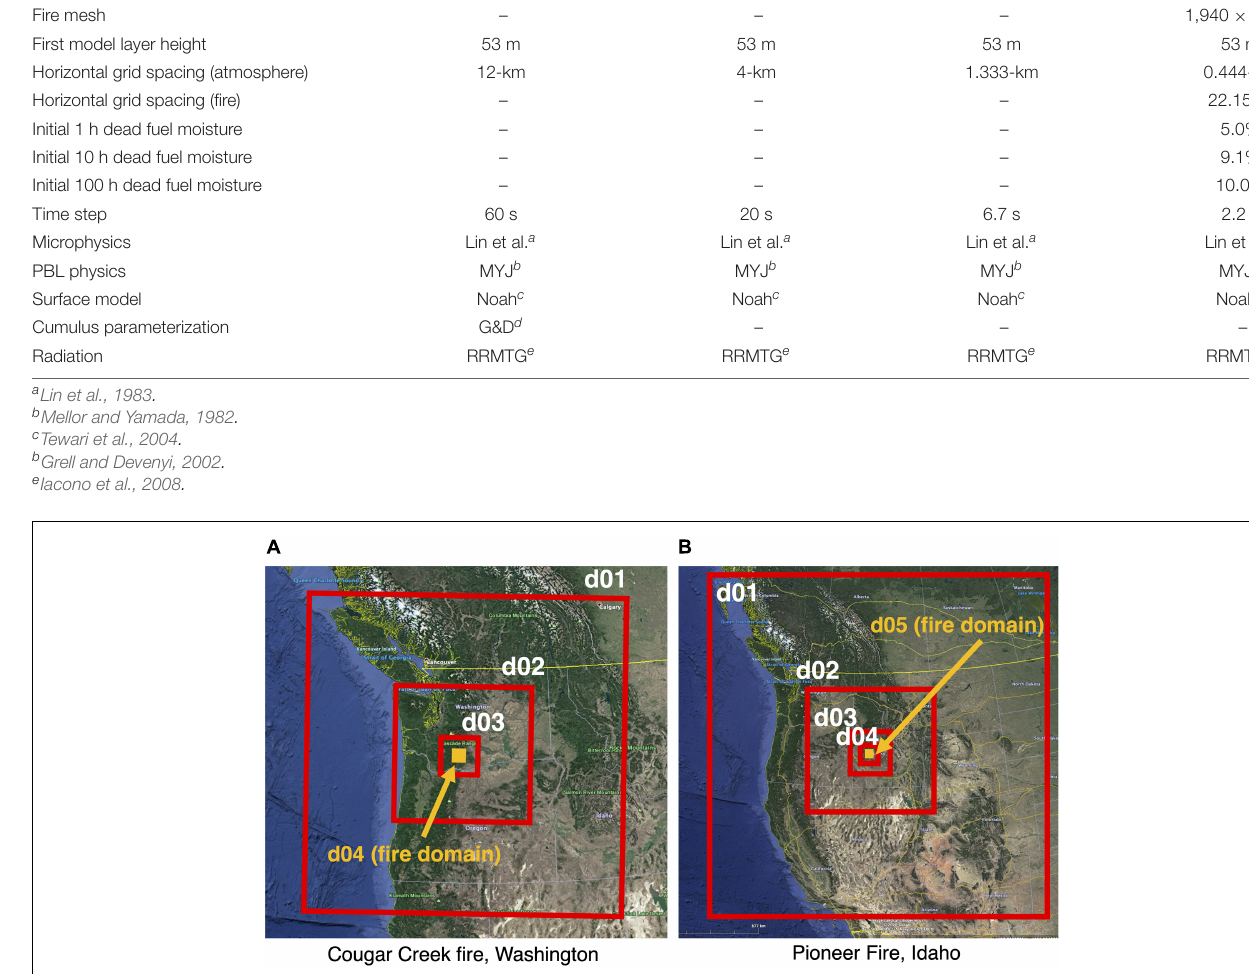
TABLE 1 | Detailed Weather Research and Forecast model (WRF) configurations for the WRF-SFIRE simulations of the Cougar Creek Fire. Domains d01 Domain dimensions X × Y × Z